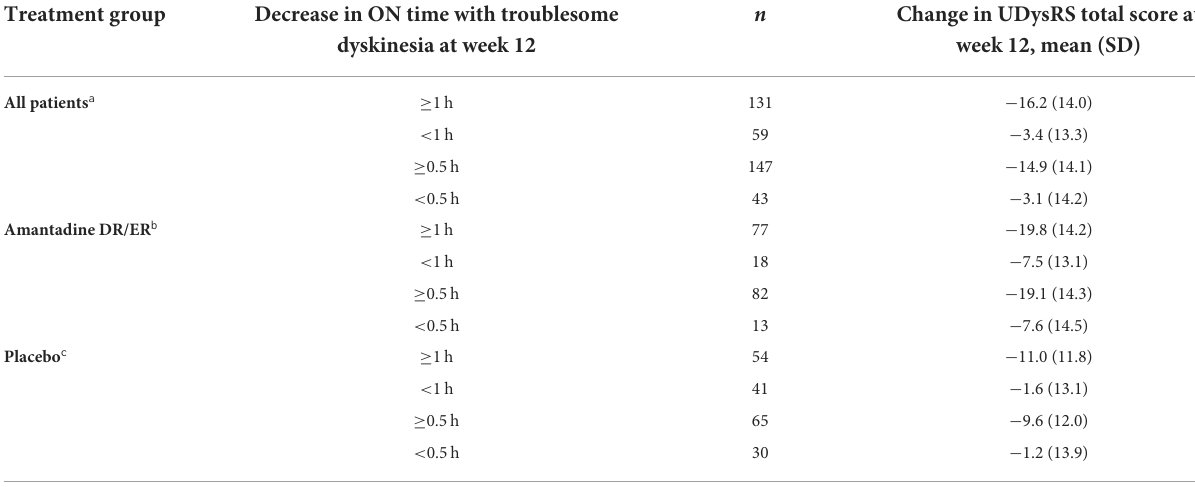
6, b n 5, c n 1. = = = week 12, mean